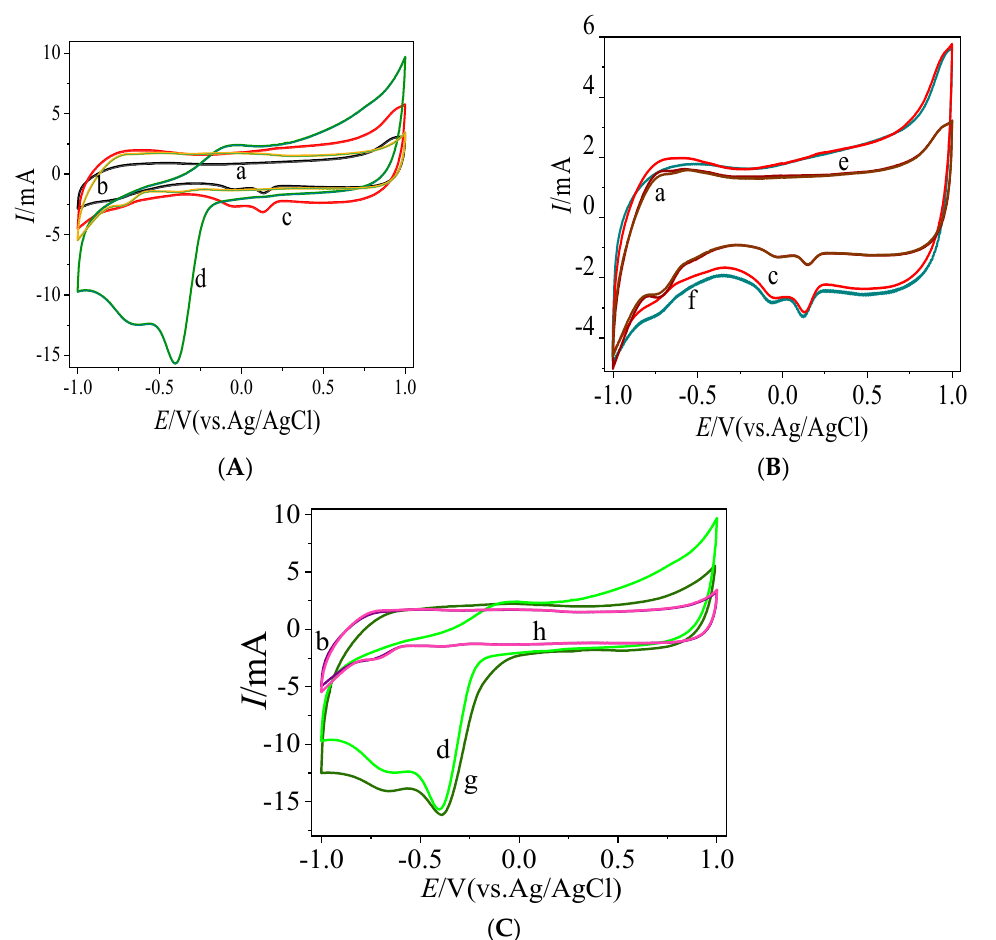
Figure 5. ( A ) Cyclic voltammetry (CV) of MC (a), MC-COOH (b), MC-GOx (c) and COOH-MC-GOx (d) in air-saturated PBS 0.1 M pH 7.0 at scan rate of 50 mV s − 1 with the addition of 10 mM glucose; ( B ) CV of MC with (a) and without glucose (e), MC-GOx with (c) and without glucose (f) in air-saturated